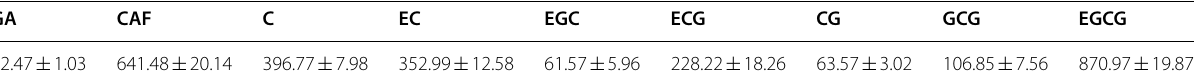
* GA gallic acid, CAF caffine, C ( gallate, EGCG (